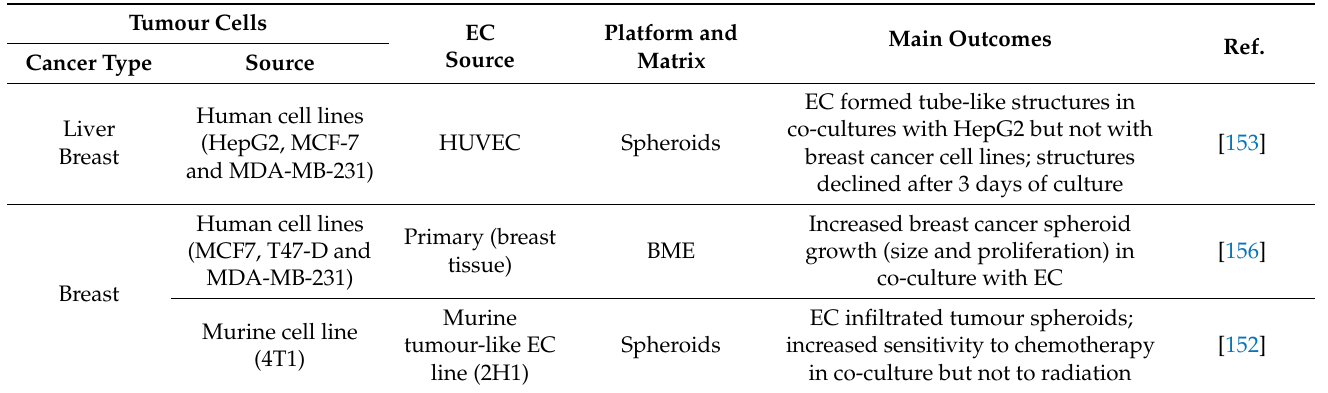
Table 2. Examples of studies developing and employing 3D co-cultures of tumour and endothelial cells (EC). Tumour Cells EC Platform and